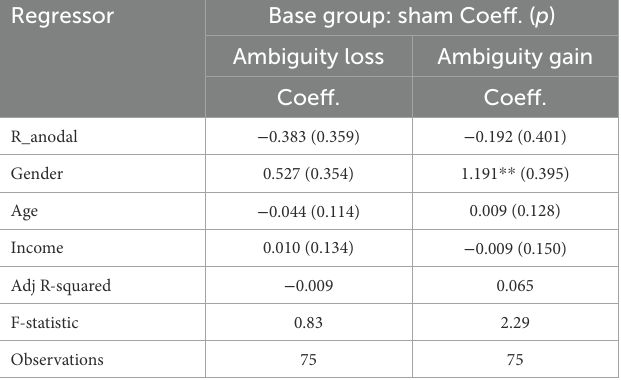
TABLE 3 The coefficients and significance of right DLPFC tDCS in the regression